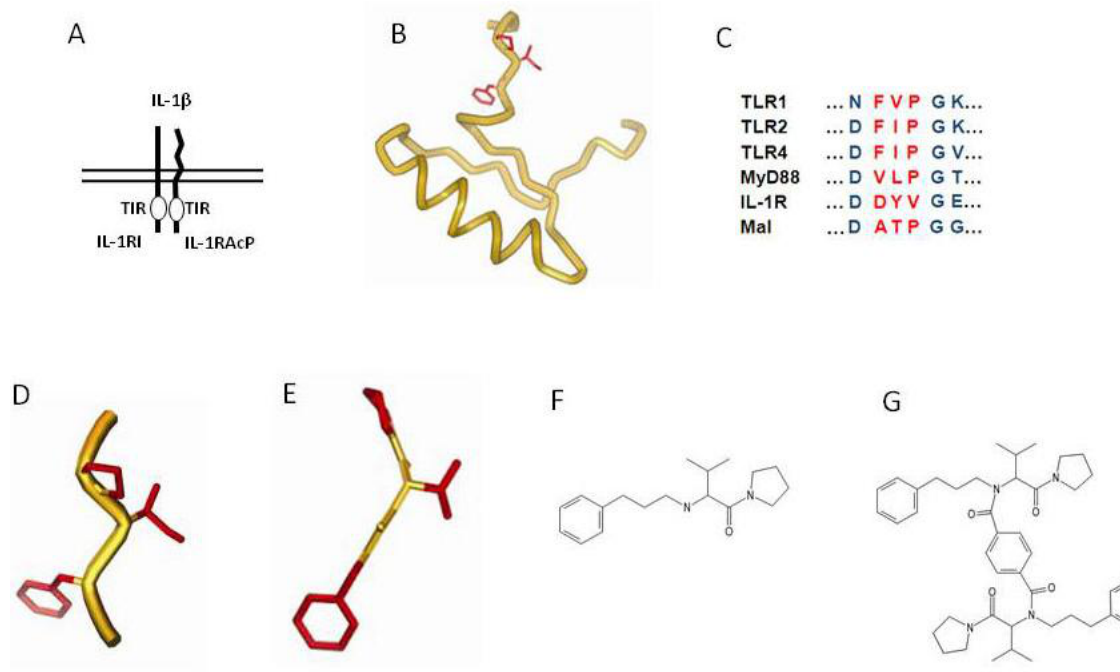
FIGURE 6. Rational design of inhibitors of the protein-protein interaction central to Toll signaling in fever and recognition of microbial products. The TIR domains found in the IL-1R1/AcP (and in the TLRs) interact via their BB loop (A). A model of the BB loop derived from the resolved crystal structure of the TIR domain (B). The synthesis of BB-loop mimics was based on the [F/Y-V/L/I-/P/G] consensus sequence found in the TIR domains of TLRs, IL-1R1, MyD88, and Mal (C). A detail of the BB-loop model (D) was used to synthesize the monomeric BB-loop mimic AS-1 (E and F). A dimeric/bifunctional BB-loop mimic, EM77, that “keeps apart the two BB domains” was also synthesized (G). AS-1 and EM77 were synthesized by the Rebek laboratory at The Scripps Research